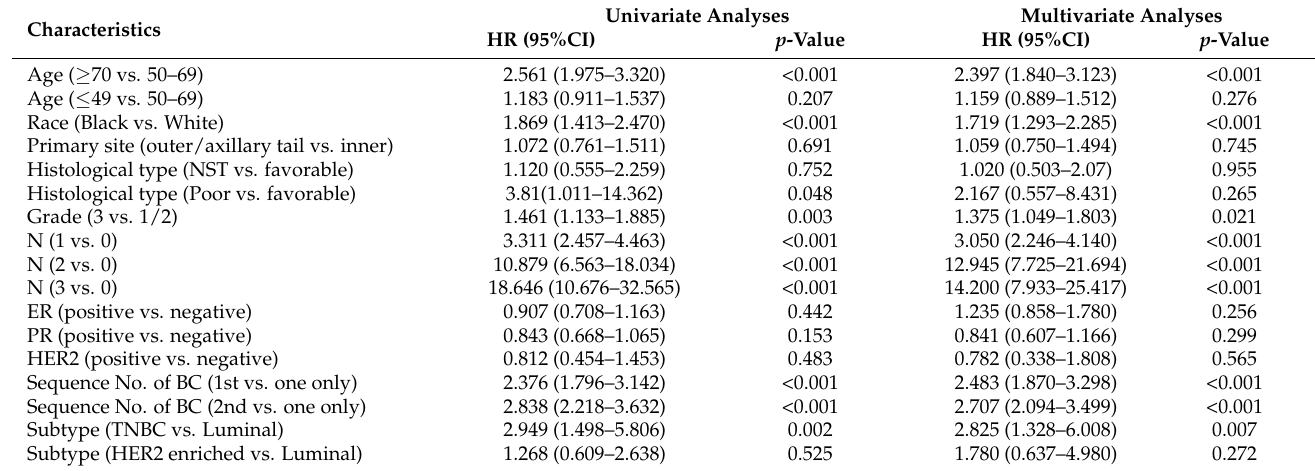
Table 2. Independent prognostic factors of breast cancer-specific survival for microinvasive breast cancer.